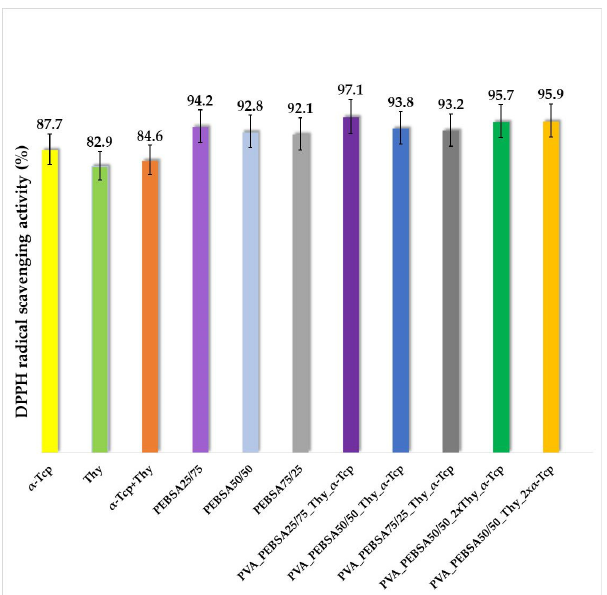
Figure 7. The antioxidant activity of the positive controls and PVA/PEBSA_Thy_ α -Tcp systems. Graphical data are expressed as mean ± standard error of the mean. According to the data obtained in this study, all samples showed antioxidant activ- ity. The most evident activity is observed in the case of the PVA_PEBSA 25/75 _Thy_ α -Tcp system (97.1%) containing the PEBSA 25/75 variant. The carbonyl groups in SA have the ability to accept hydrogen; therefore, increasing the content of SA in the matrix deter- mines a better free radical scavenging activity. At the same time, the cumulative antiox- idant efficiency of Thy and α -Tcp in combination with the PEBSA copolymer has a re- markable synergistic effect, between 93.2% and 97.1% (Figure 7). In summary, the mix- ture of the two bioactive compounds and PEBSA produces new cryogels with potential applications as wound dressings whose therapeutic effects are superior to the effects produced by each individual component. 3. Conclusions The encapsulation of hydrophobic molecular compounds into a polymer matrix has emerged as a method to modulate the low solubility in water and a promising approach to preserve their chemical integrity, efficacy, but also their controlled release in a pul- sating or continuous regime. Three-dimensional scaffolds based on cryogels are strong candidates and of particular interest for this purpose [33]. In this study, our group used this strategy to develop new cryogels with antimicrobial and antioxidant activity based on PVA, PEBSA, Thy, and α -Tcp obtained by a repeated freeze–thaw process. On the one hand, Thy shows antimicrobial properties on a wide spectrum of bacteria (e.g., S. aureus , Bacillus licheniformis , E. coli , P. vulgaris, C. albicans , etc.) [16] and on the other hand, the encapsulation of α -Tcp confers antioxidant properties to the PVA/PEBSA_Thy system, targeting a double therapeutic effect due to the presence of both bioactive molecular agents. The new bioactive compounds prepared by encapsulation of Thy and α -Tcp into the PVA/PEBSA system were investigated from the point of view of the influence of the